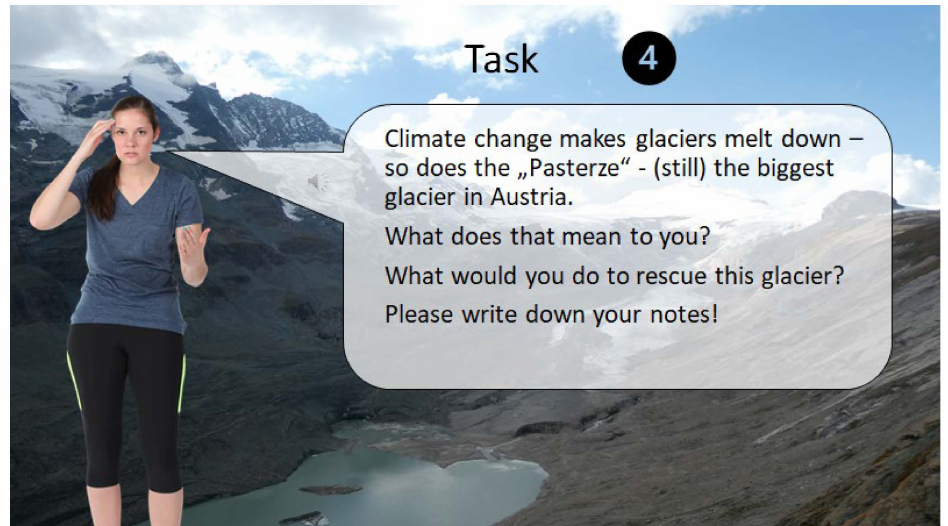
Figure 3. Task provided by the Pedagogical